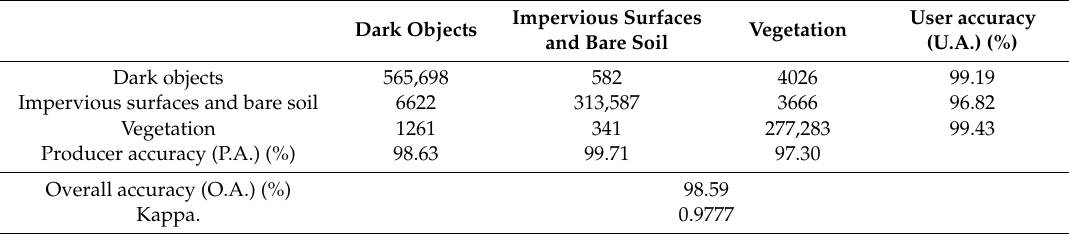
Figure 9. The classification result at the top node. Table 3. Confusion matrix and accuracy of the result at the top node.